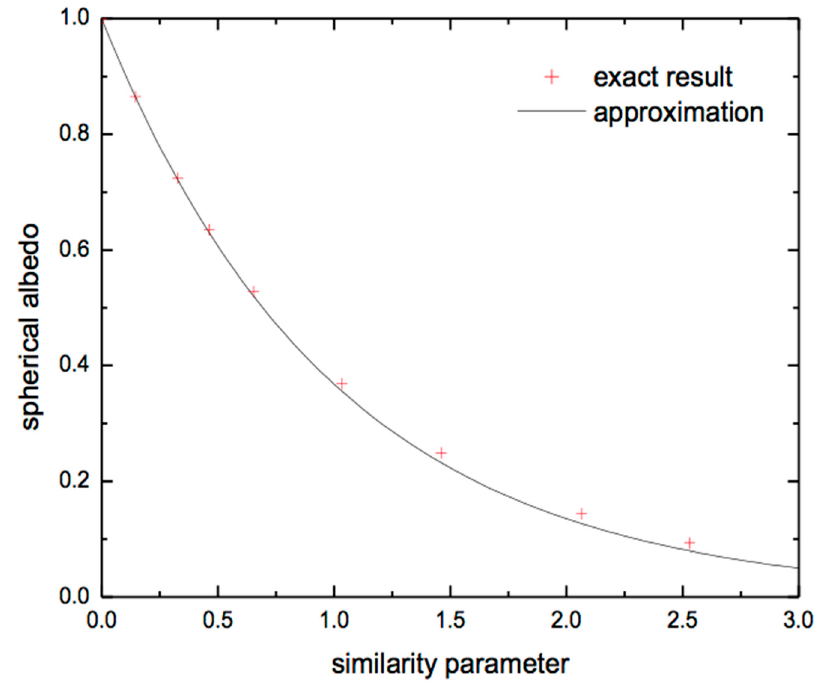
Figure 4. The spherical albedo derived using Equation (13) and exact radiative transfer calculations.